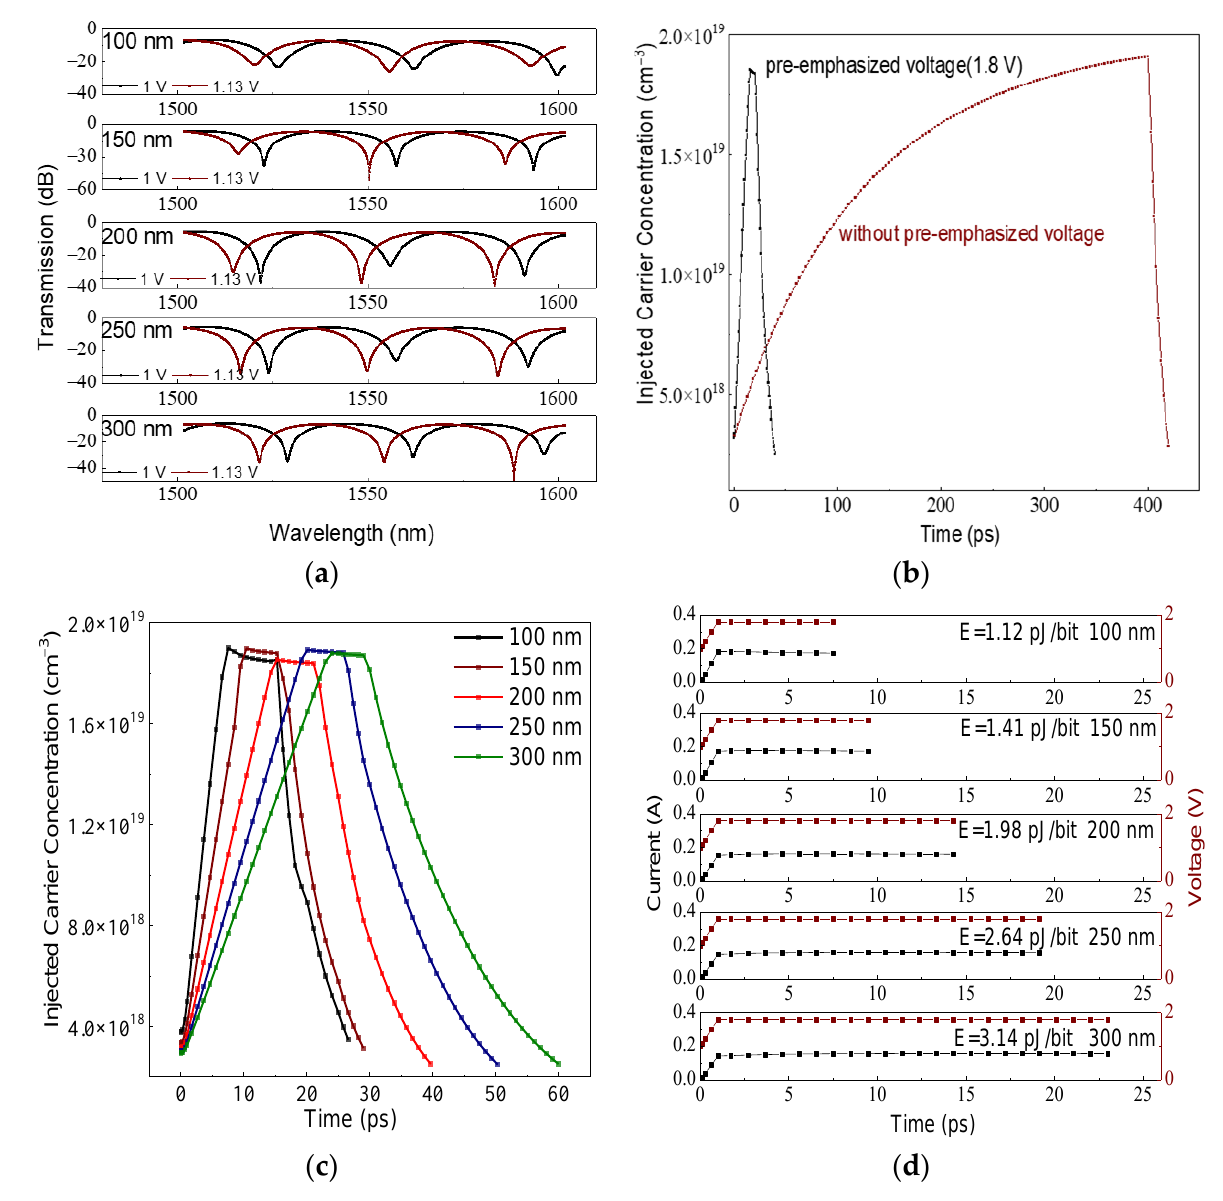
Figure 3. ( a ) The transmission curve as “on-state” and “off-state” voltage is applied; ( b ) the change in carrier concentration with time for different voltage conditions of the CIPMRM; ( c ) the change in carrier concentration with time for different widths of CIPMRMs; ( d ) the IV-t curve for different widths of